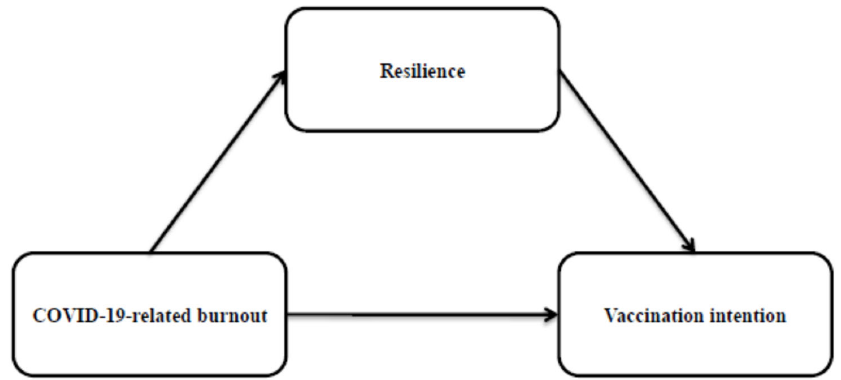
Figure 1. Structural model depicting the relationships between COVID-19-related burnout, resilience, and vaccination intention.